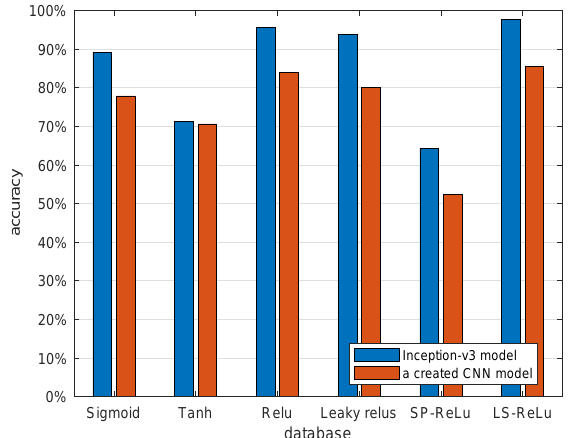
Figure 16. The recognition results of CMU-PIE database based on two different CNN